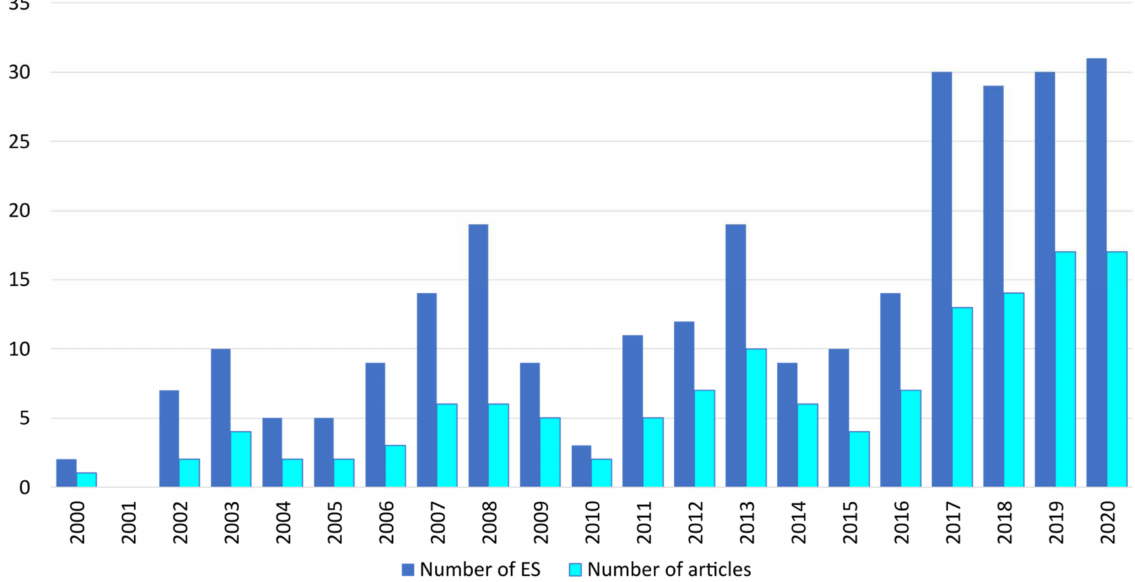
Figure 3. Time distribution of the published articles and detected ES per year (between 2000 and